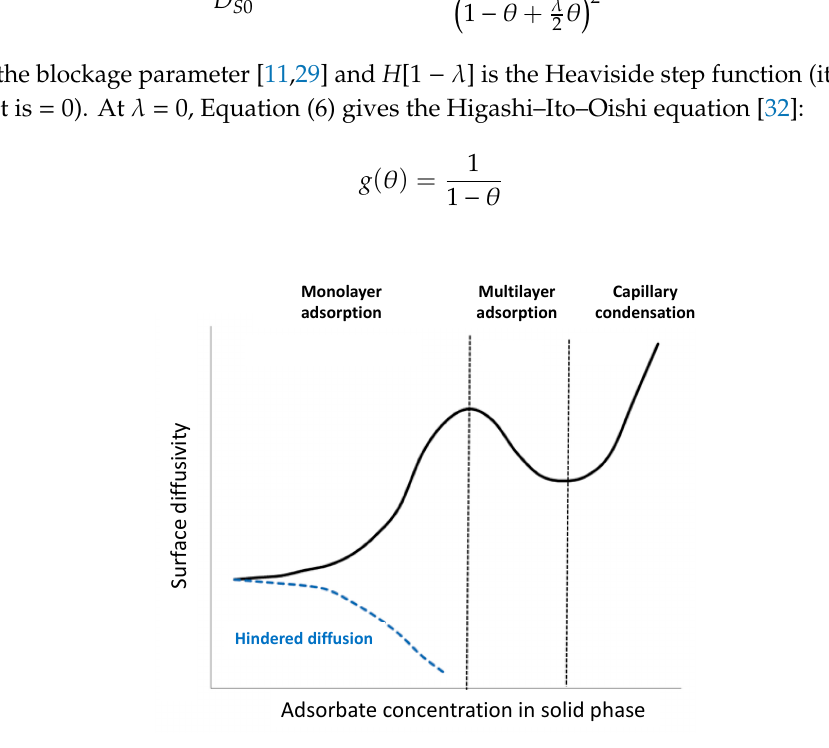
Figure 1. Surface diffusivity as a function of adsorbate concentration in solid phase. Adapted version from Choi et al. [12].